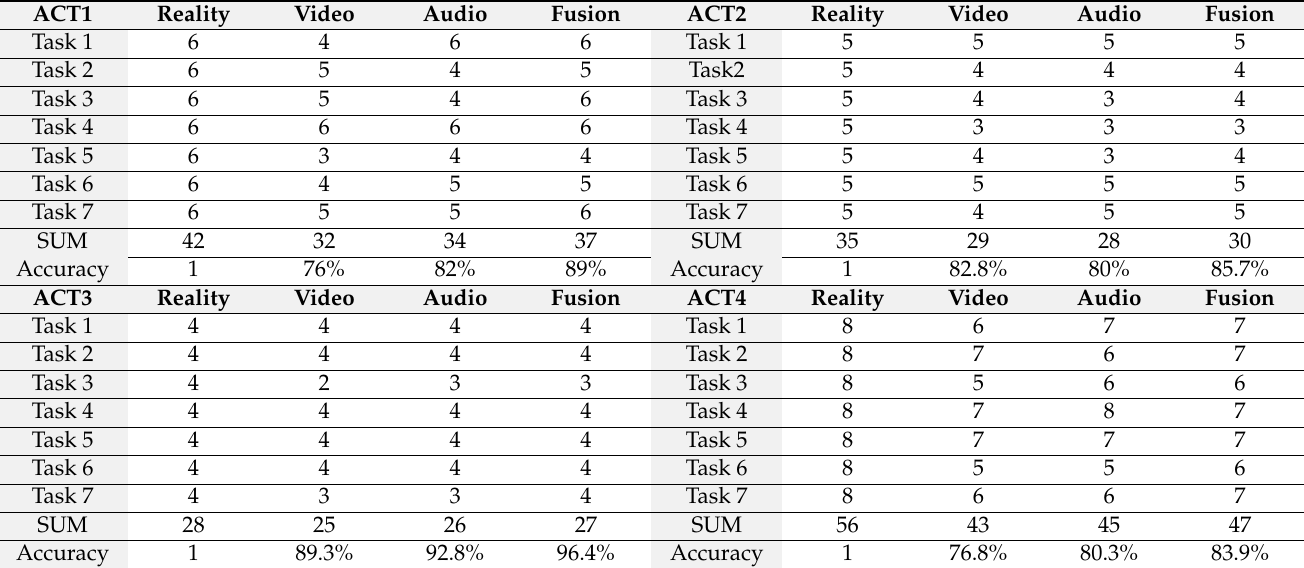
Table 8. Comparison of fusion and single-module